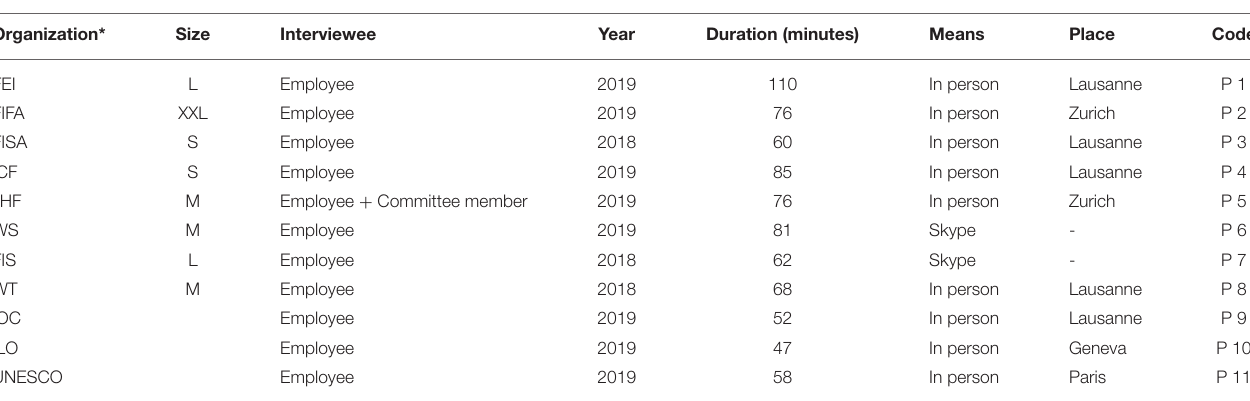
TABLE 2 | List of